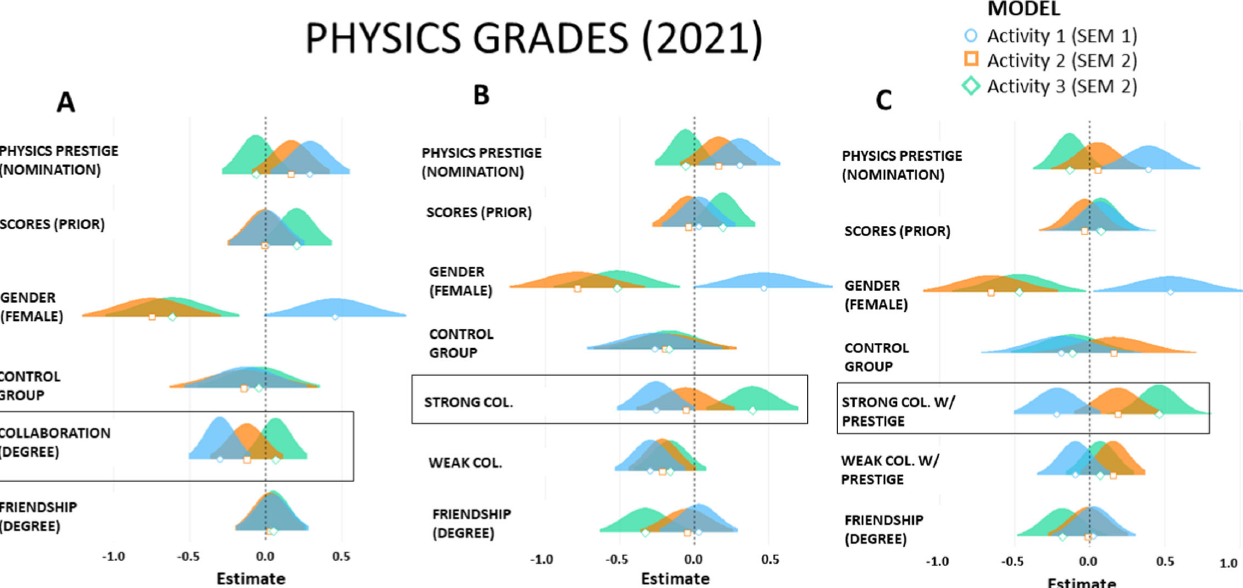
FIG. 7. Graphic depiction of OLS multiple linear regression coefficient comparison between activity 1 at the end of semester 1 (light blue); activity 2 at the beginning of semester 2 (orange); and activity 3 at the end of semester 2 (light blue). Coefficient distributions at the left from the dashed line indicate negative effects, and positive coefficients are located at the right. Key predictors are enclosed in black boxes: collaboration (degree), model A; strong collaboration, model B; and strong collaboration with high prestige students in physics, model